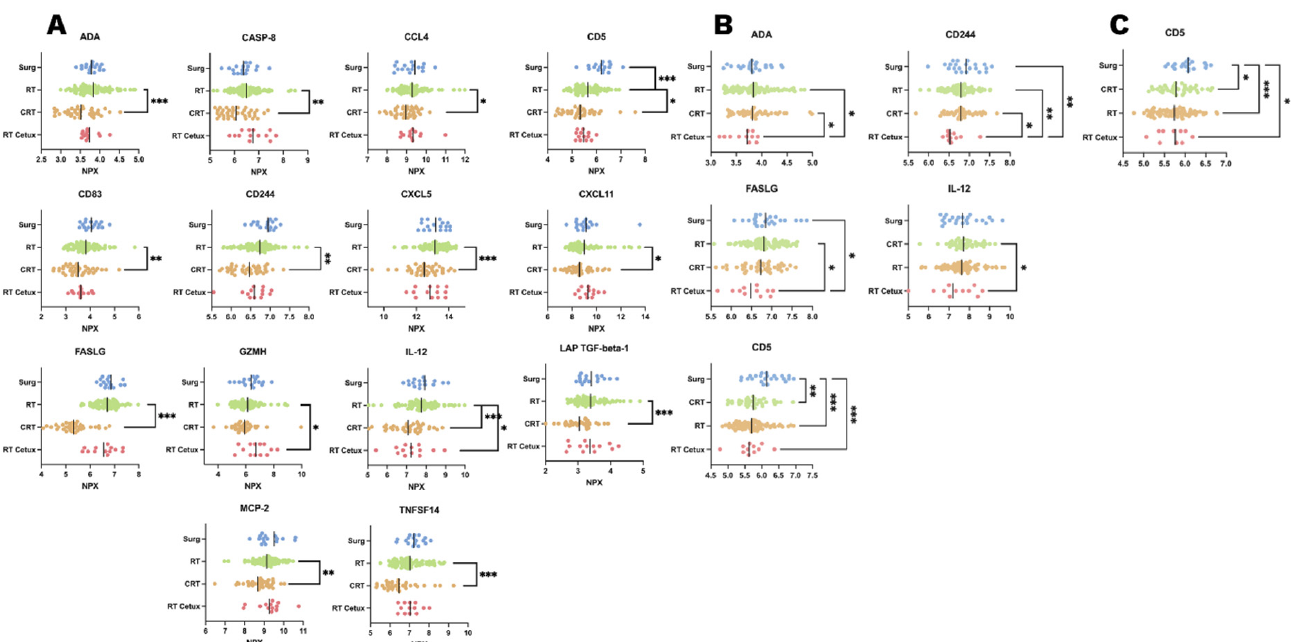
Figure 2. Proteins exhibiting significant differences between treatment groups at 7 weeks after the start of treatment for head and neck cancer ( A ), 3 months after the termination of treatment ( B ), and 12 months after the termination of treatment ( C ). (* p ≤ 0.05; ** p ≤ 0.01; *** p ≤ 0.001).